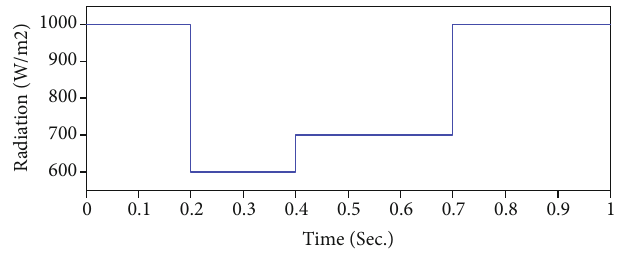
Figure 18: The radiation conditions of panel 3.